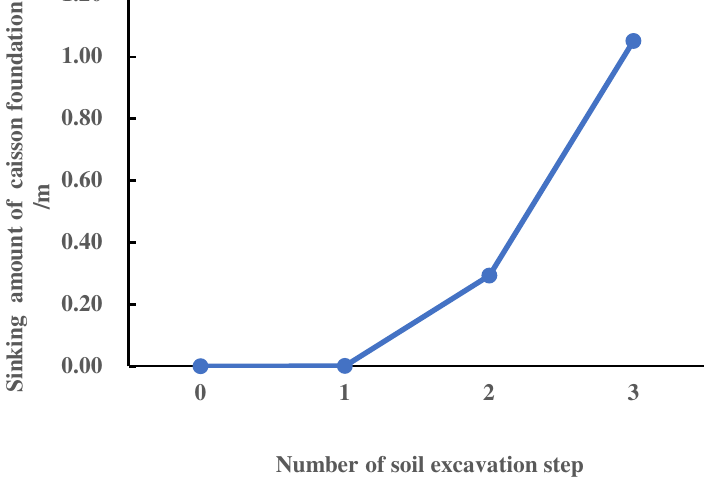
Figure 11. Sinking amount corresponding to the step of soil excavation.